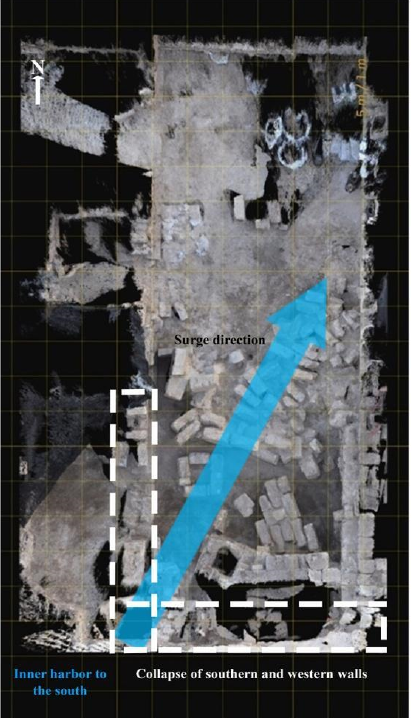
Figure 8. Tsunami corridor. Based on the damage to the southern and southwestern walls and orientation of the collapsed building stones, the dominant destruction came from the southern harbor- facing side of the corridor. Structure by Motion created at CHEI, University of California-San Diego.